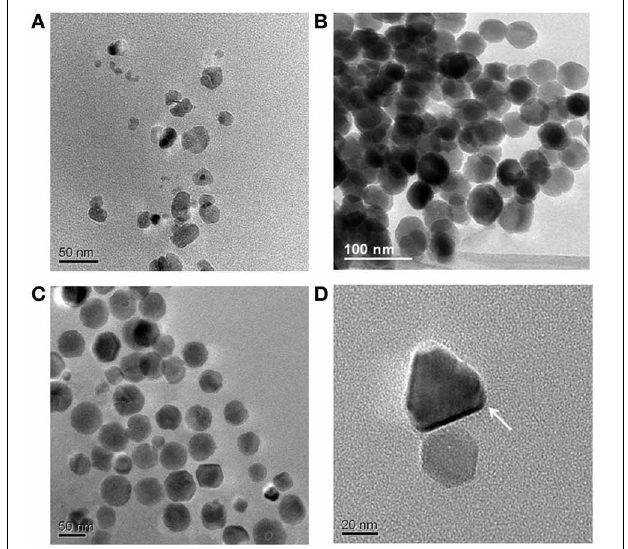
FIGURE 1 | TEM images of magnetite crystals synthesized by M. gryphiswaldense cells grown at 28 ◦ C and at different pH values: (A) 6.0; (B) 7.0; (C) 8.0; (D)